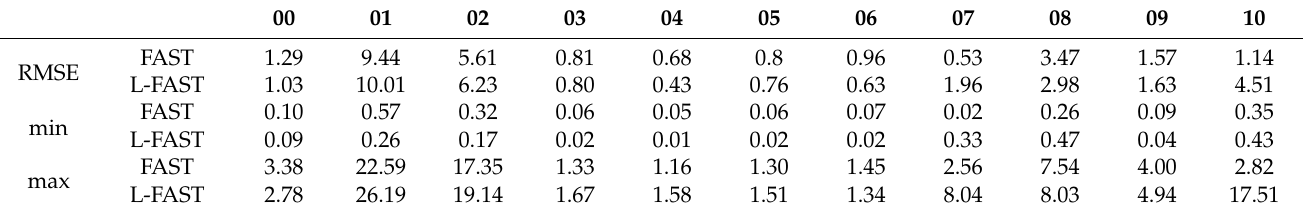
Table 4. The RMSE, min and max errors of ATE for sequences from 00 to 10 (unit: m).